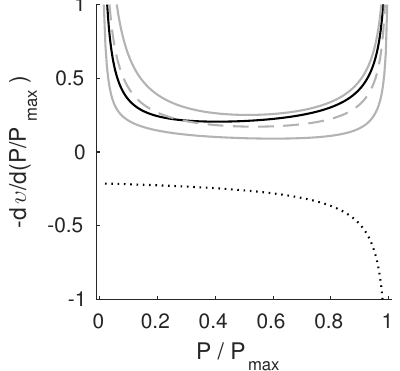
Figure 2. Cell efficiency vs. normalized cell power. Dotted line marks the high current branch above the maximum power point.